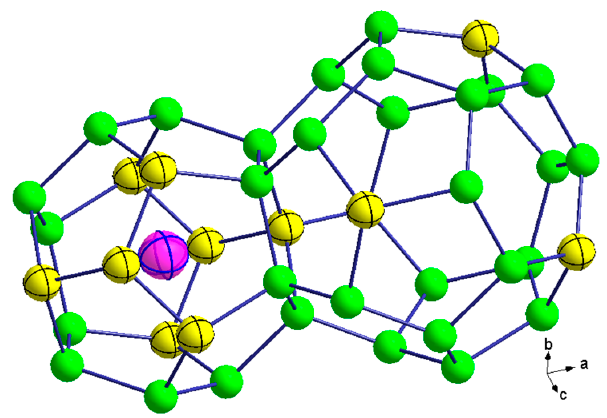
Figure 1. The dodecahedron (K,Ba) and hexakaidecahedron (empty) with thermal ellipsoids for all atoms corresponding to 95% probability for K 2.9(4) Ba 13.1(2) Ga 23.2(3) Sn 112.7(5) . Pink, yellow, and green spheres represent K/Ba (16 c ), Sn (32 e ), and Ga/Sn (8 a and 96 g ), respectively.